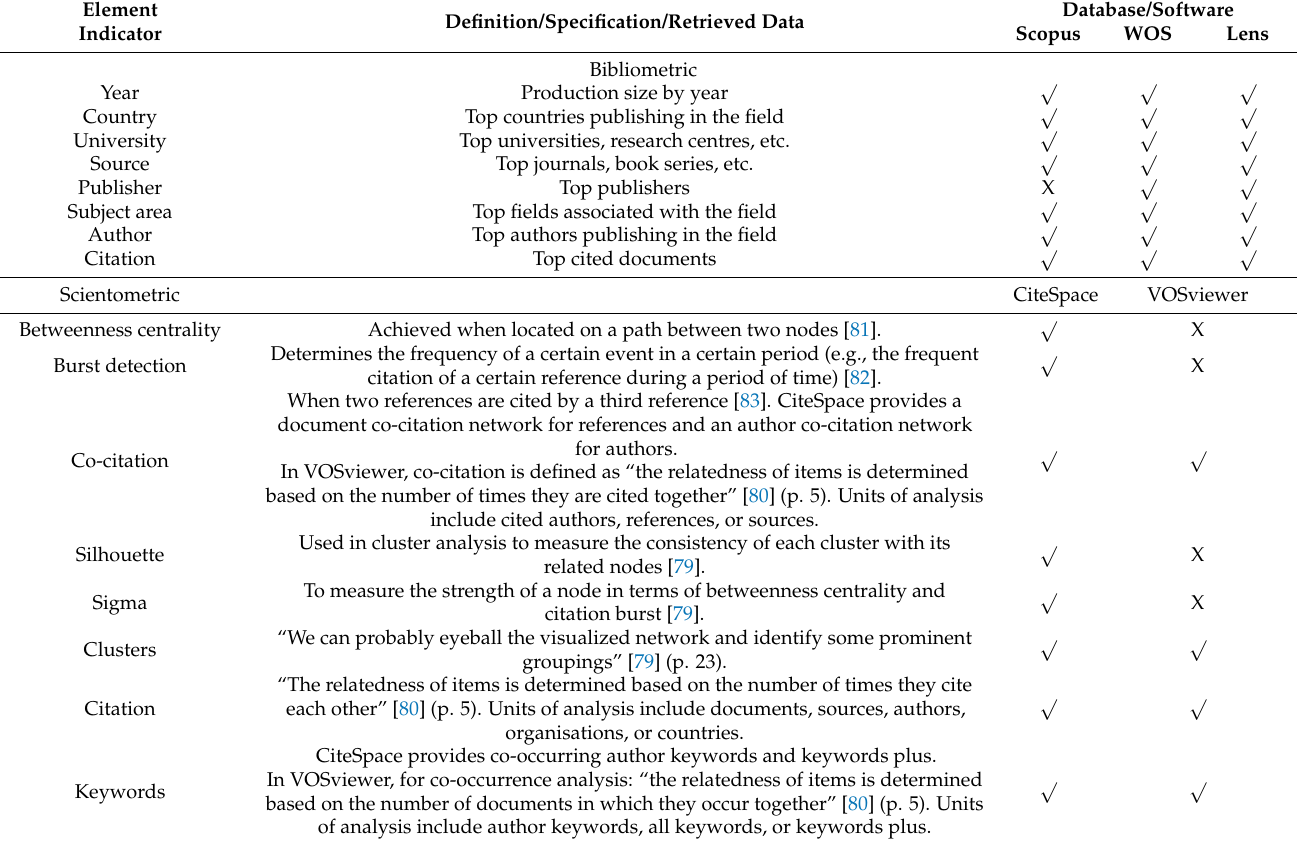
Table 3. Bibliometric and scientometric indicators to measure pragmatic language